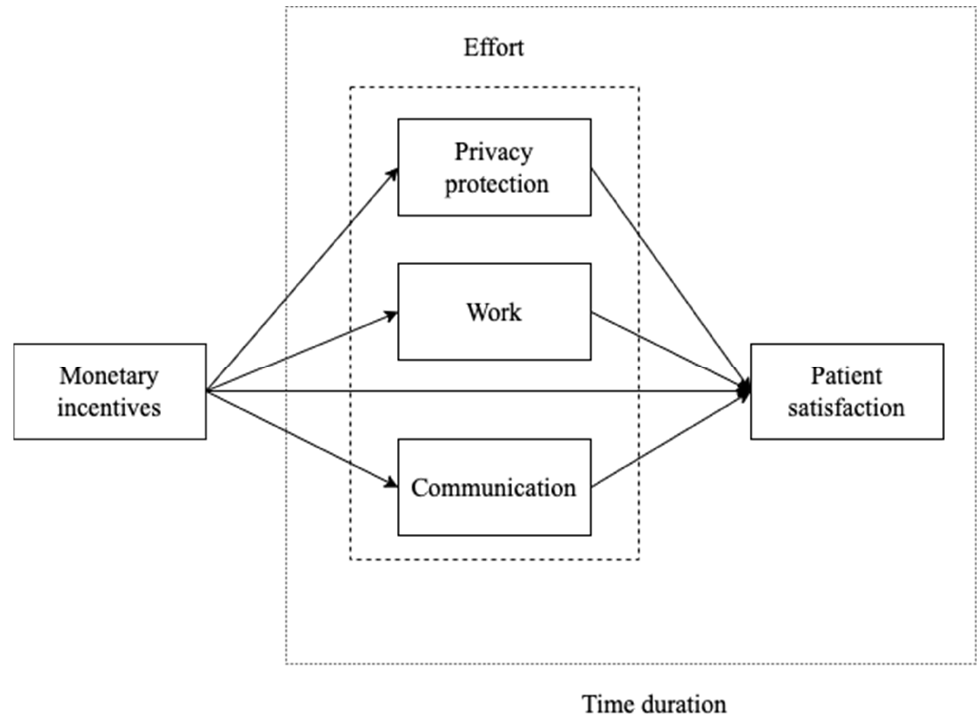
Figure 1. The conceptual framework of the study identifying the effect of monetary incentives on effort and performance.